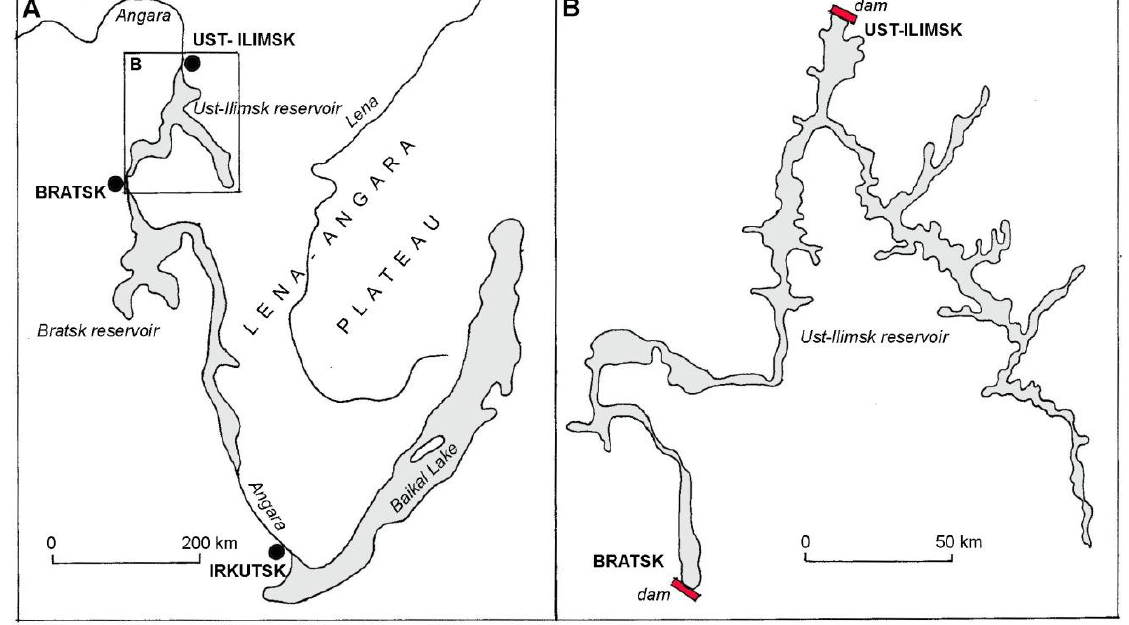
Fig. 1. Location of the Ust-Ilimsk water